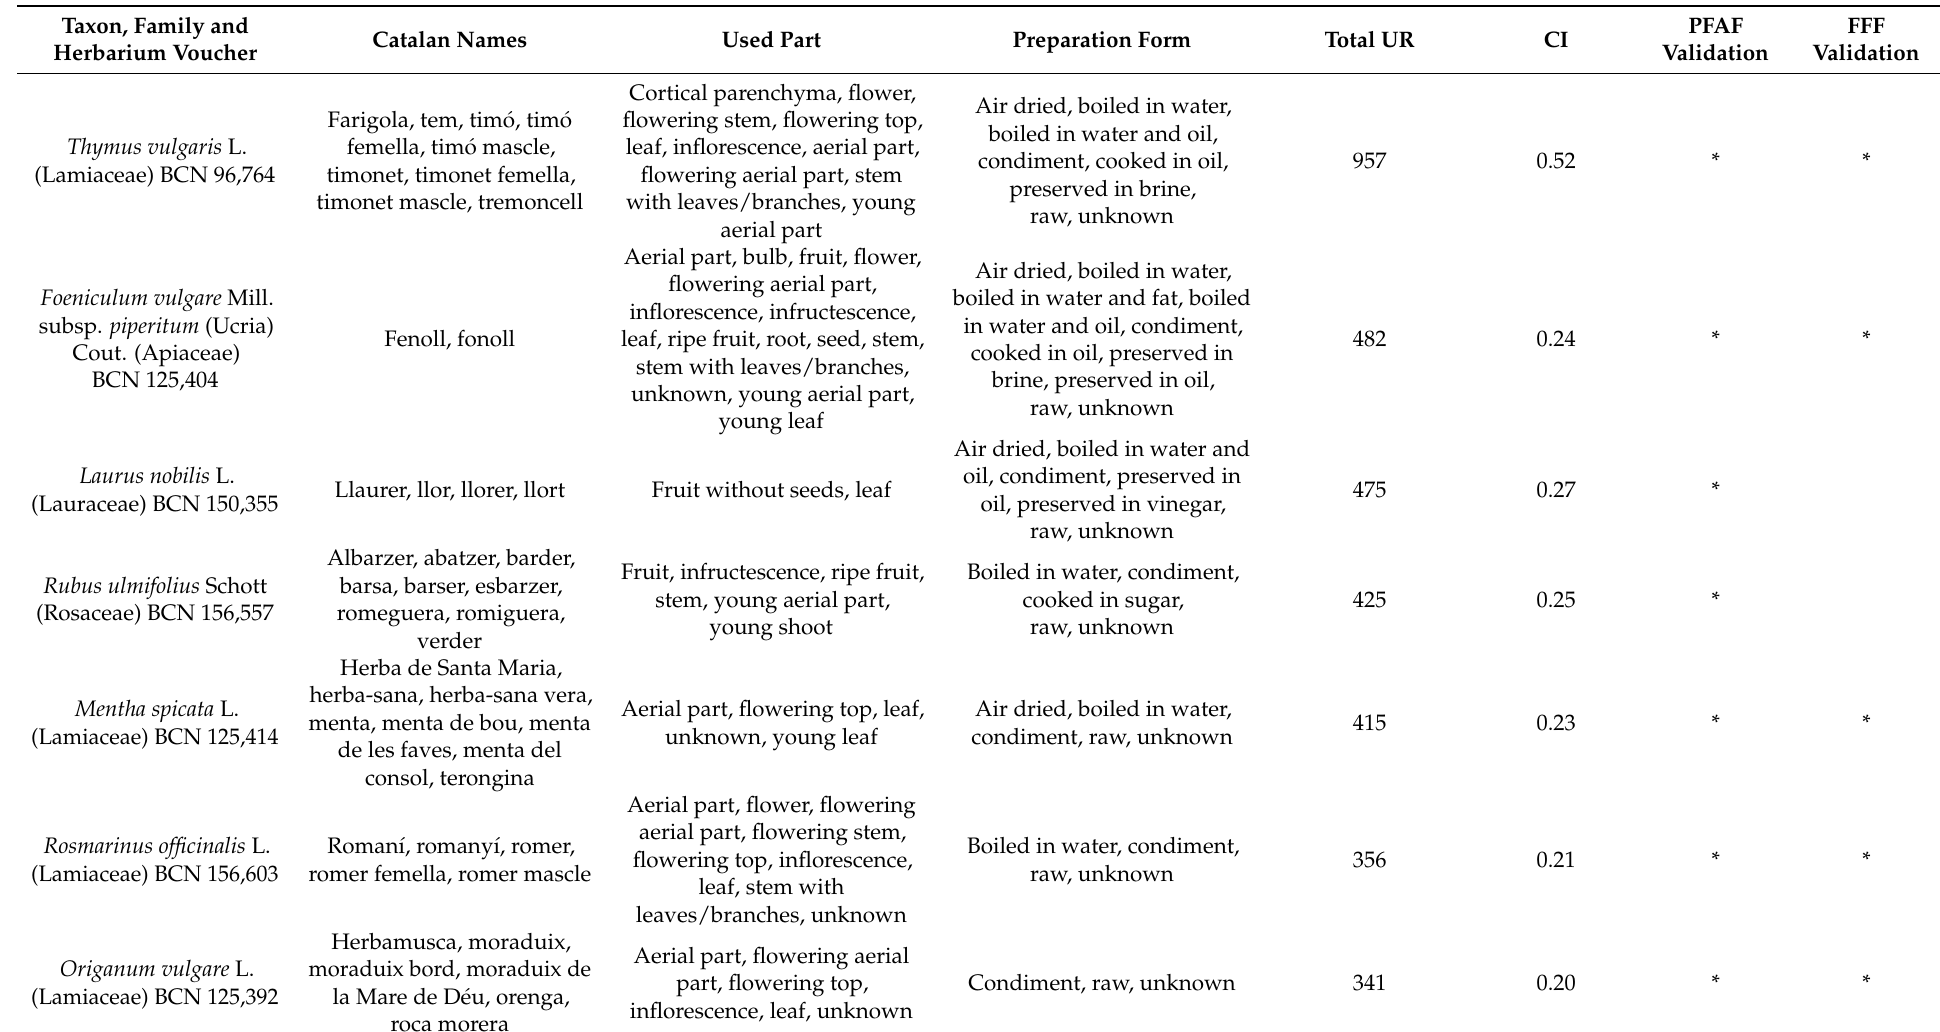
Table 1. The top 30 taxa and their preparation